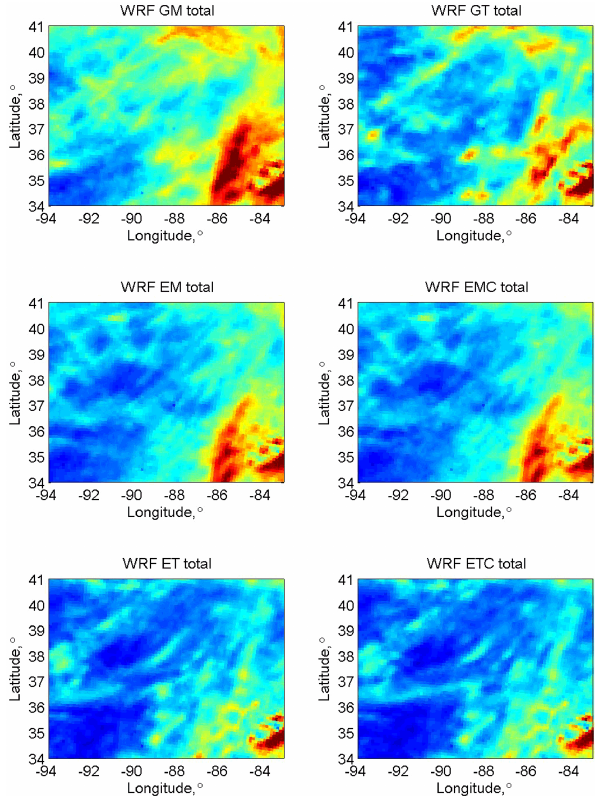
Figure 5. Total precipitation from each WRF run